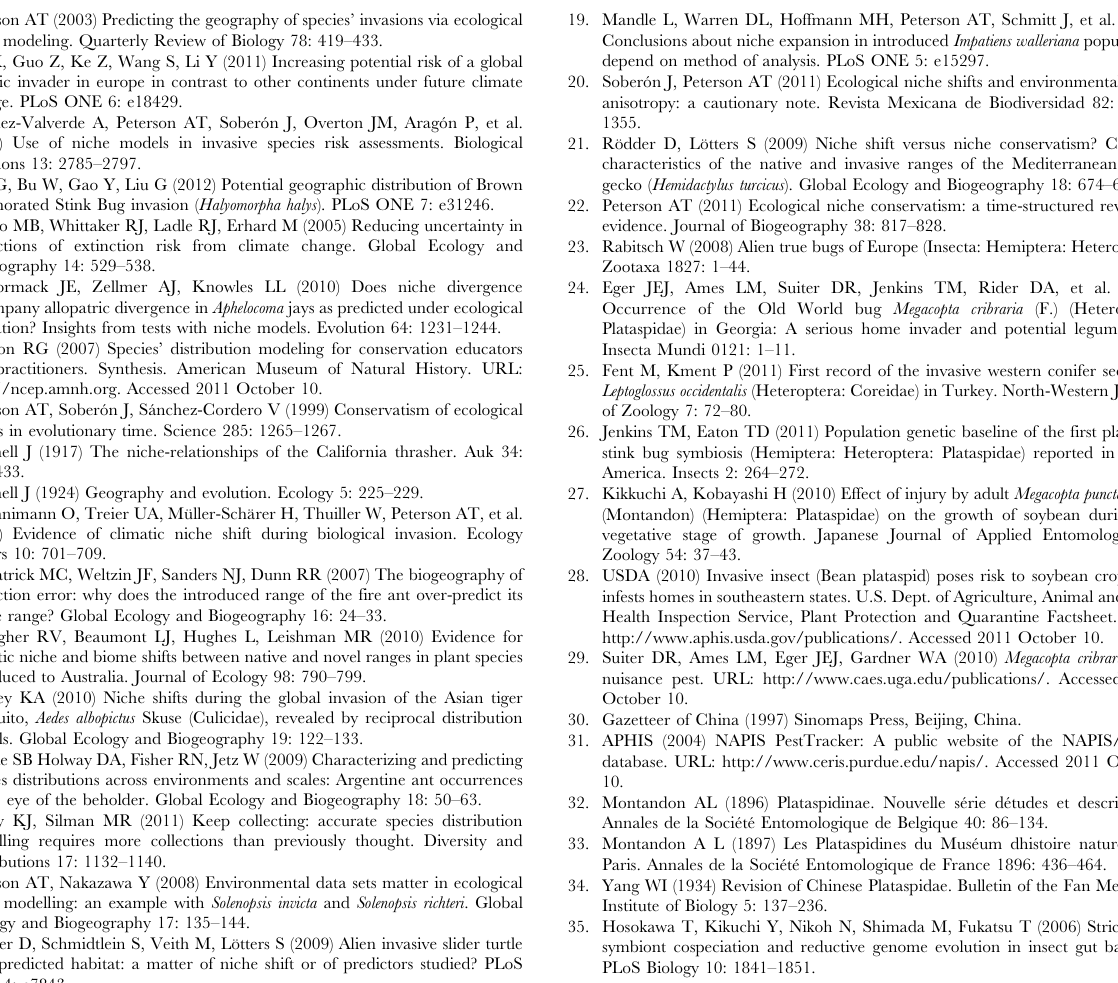
Figure S1 MESS map for Dataset I in model compari- son. Areas in red indicate one or more environmental variables outside the range present in the training data. Figure S2 MESS map for Dataset II when transferred the model worldwide. Areas in red indicate one or more